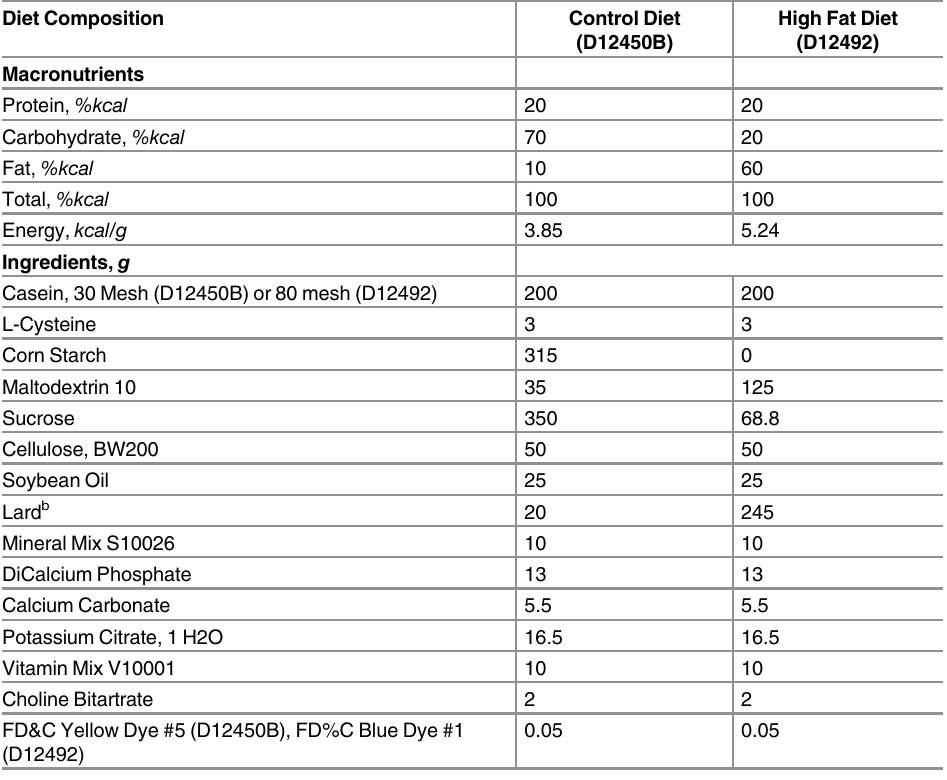
Table 1. Composition of Control and High Fat Diets a